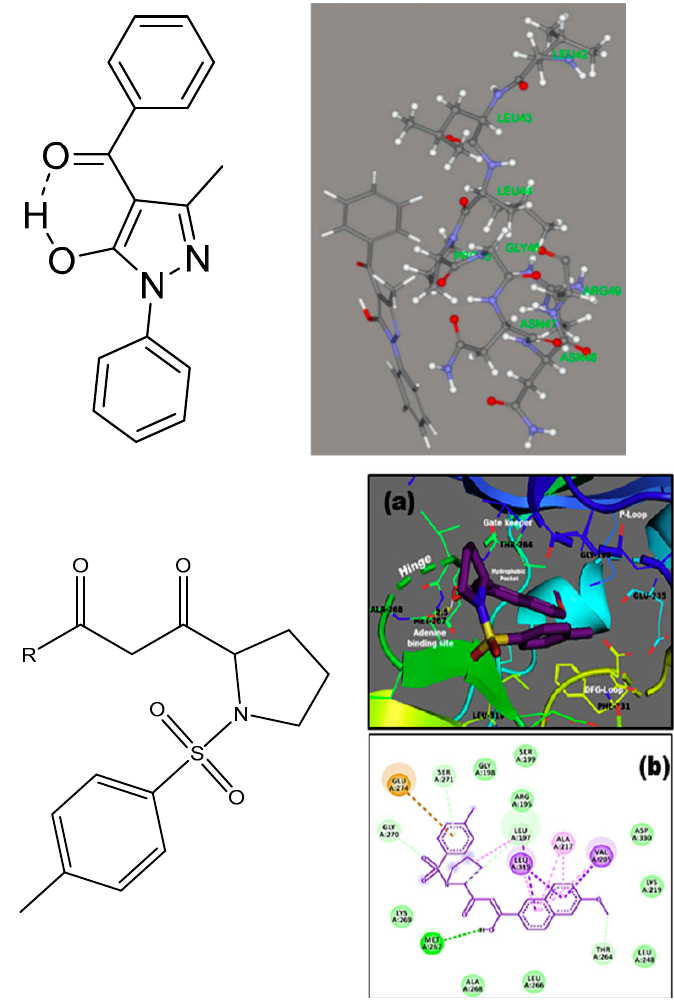
Figure 7. Top: One enol-form of HQPh and the preferred tautomer docked to the ICAM-1 protein from [44]. With permission from Elsevier. Bottom : β -Diketones derived from L-proline. R can be phenyl, p-toluene, p-Cl, Br, I-phenyl, 2,4-difluoro- and 2,4-dichorophenyl, 2-fluoro-4-bromo- and 2-methyl-4-iodophenyl, and 2-furanyl and 2-naphthyl-6-methoxy. Docking of the latter in the binding site of PTK6. (a). Showing the docking. (b). Showing the amino acid involved. Taken from [46] with permission from Elsevier.